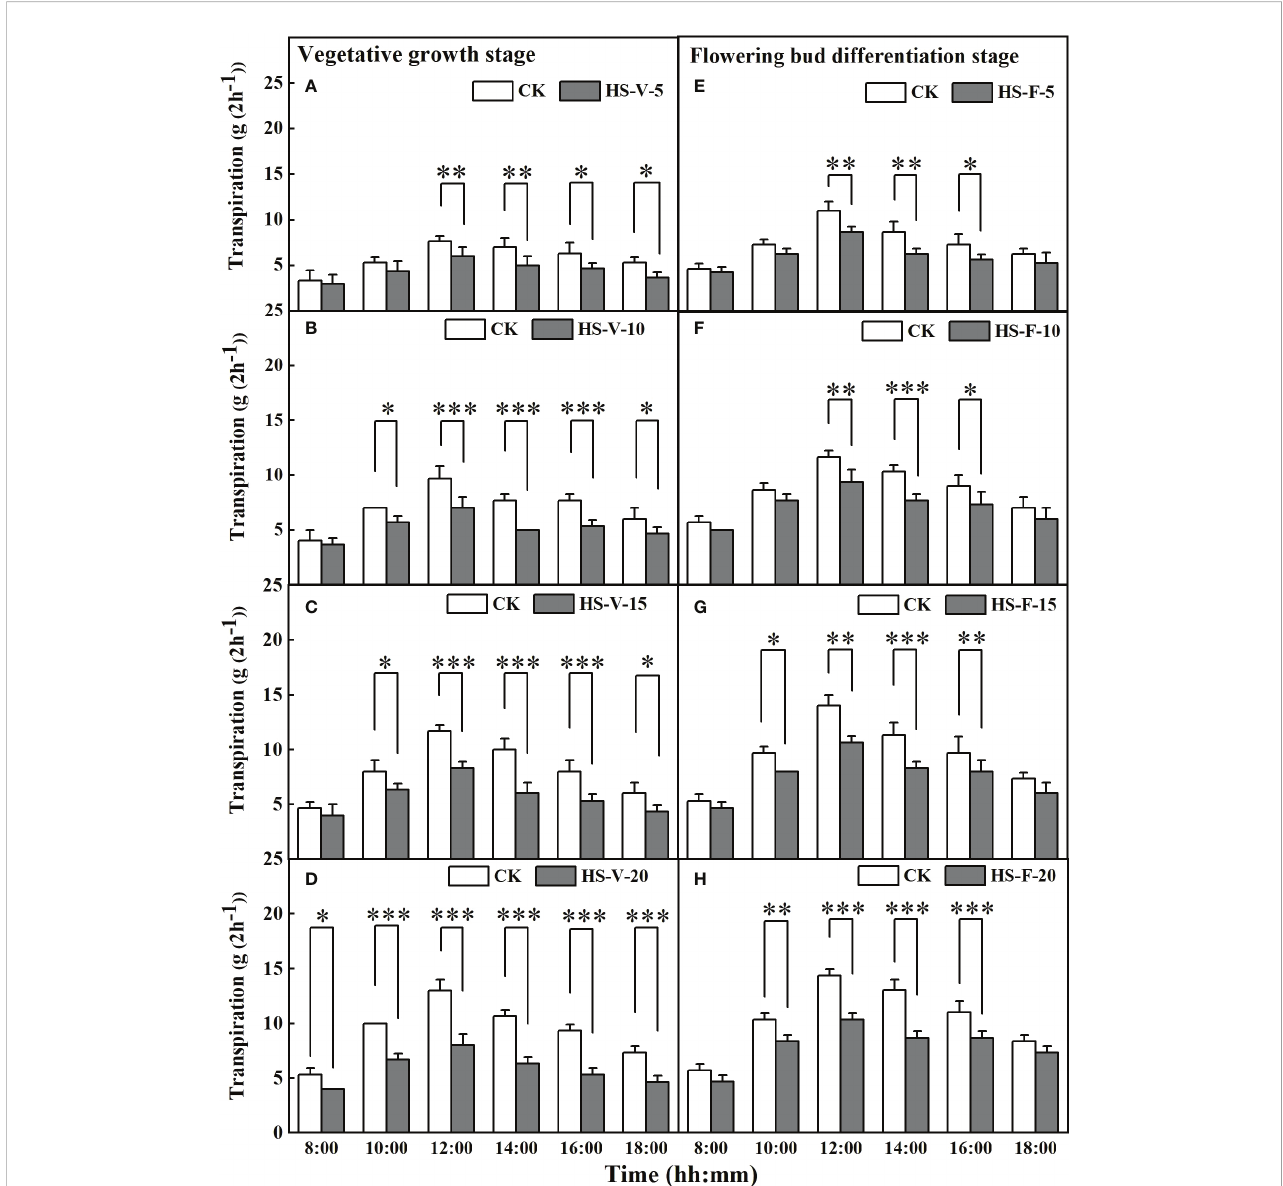
FIGURE 6 Diurnal variation of transpiration under different temperature treatments during the vegetative growth (A – D) and fl owering bud differentiation stages (E – H) . *, **, and *** represent the signi fi cant level at P <0.05, P <0.01, and P <0.001, respectively. The error bars represent standard deviation